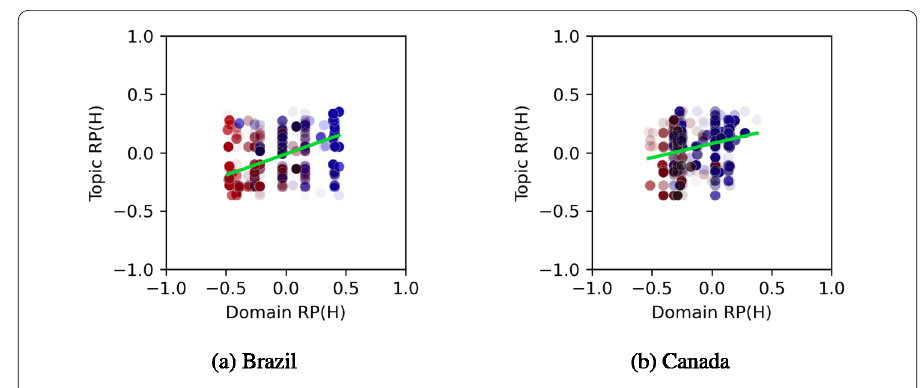
Figure 13 Correlation between retweeted Domain RP ( H ) and Topic RP ( H